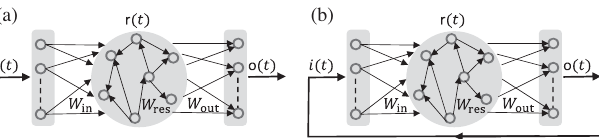
FIG. 1. The sketch of the conventional reservoir computing paradigm in (a) training and (b) predicting phases. The vectors i ð t Þ , r ð t Þ , and o ð t Þ describe the injected input, the corresponding reservoir states, and the trained output, respectively. All three layers of the network are described by W interconnection matrices. The first two are initialized randomly and are held fixed throughout the whole computation process, while the last one is trained by linear regression. In the prediction phase, the feedback loop from the predicted output defines the next injected